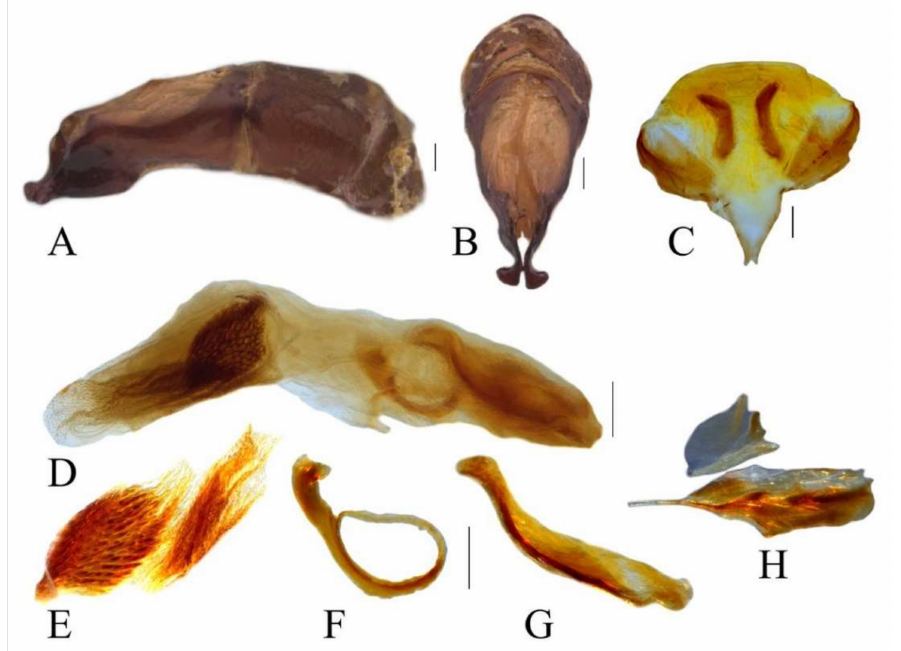
Figure 3. Bajacanthon subgen. nov. ( A ), aedeagus of Canthon ( Bajacanthon ) obliquus ; ( B ), parameres; ( C ), genital segment; ( D ), internal sac of aedeagus; ( E ), raspules; ( F ), ring sclerite; ( G ), sigmoid sclerite; ( H ), flagellum. Scale = 0.2